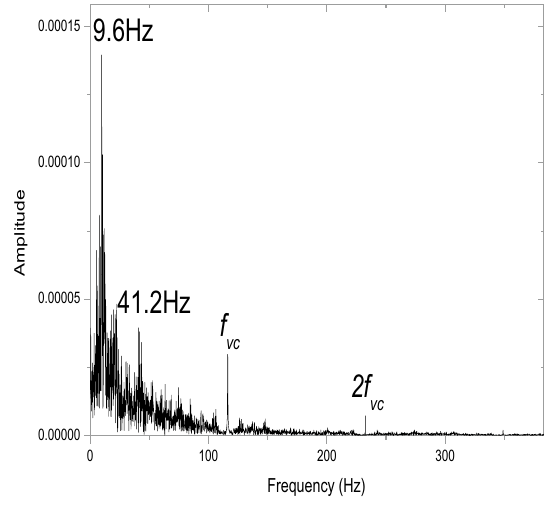
Fig. 10 Spectrum diagram (n = 2000 rpm)